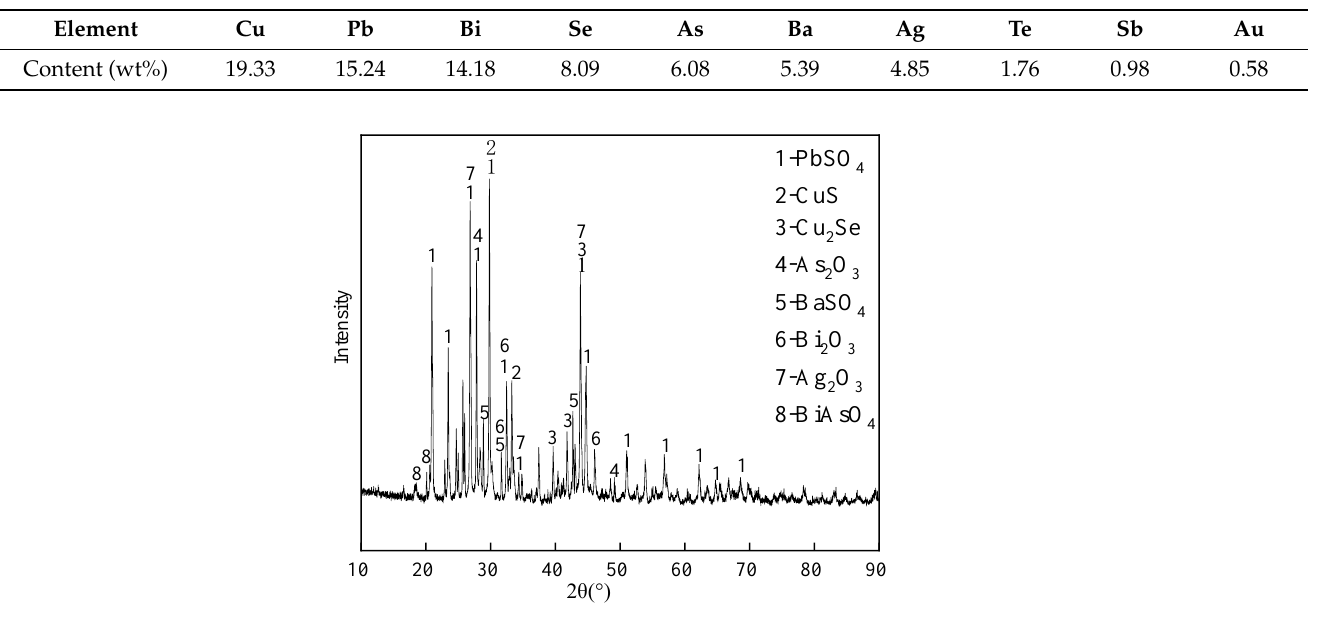
Table 1. Main chemical components of copper anode slime.